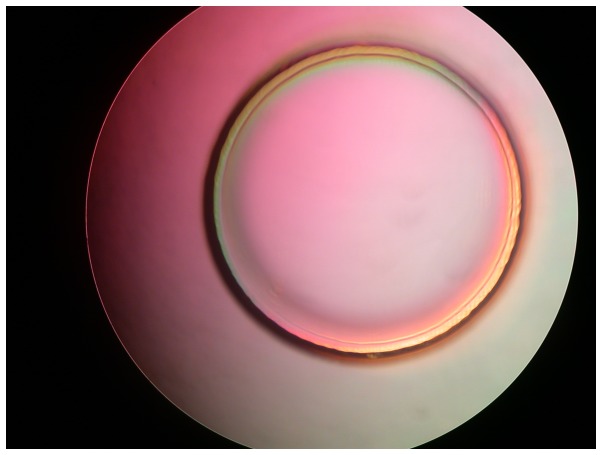
Bonding design sketch.